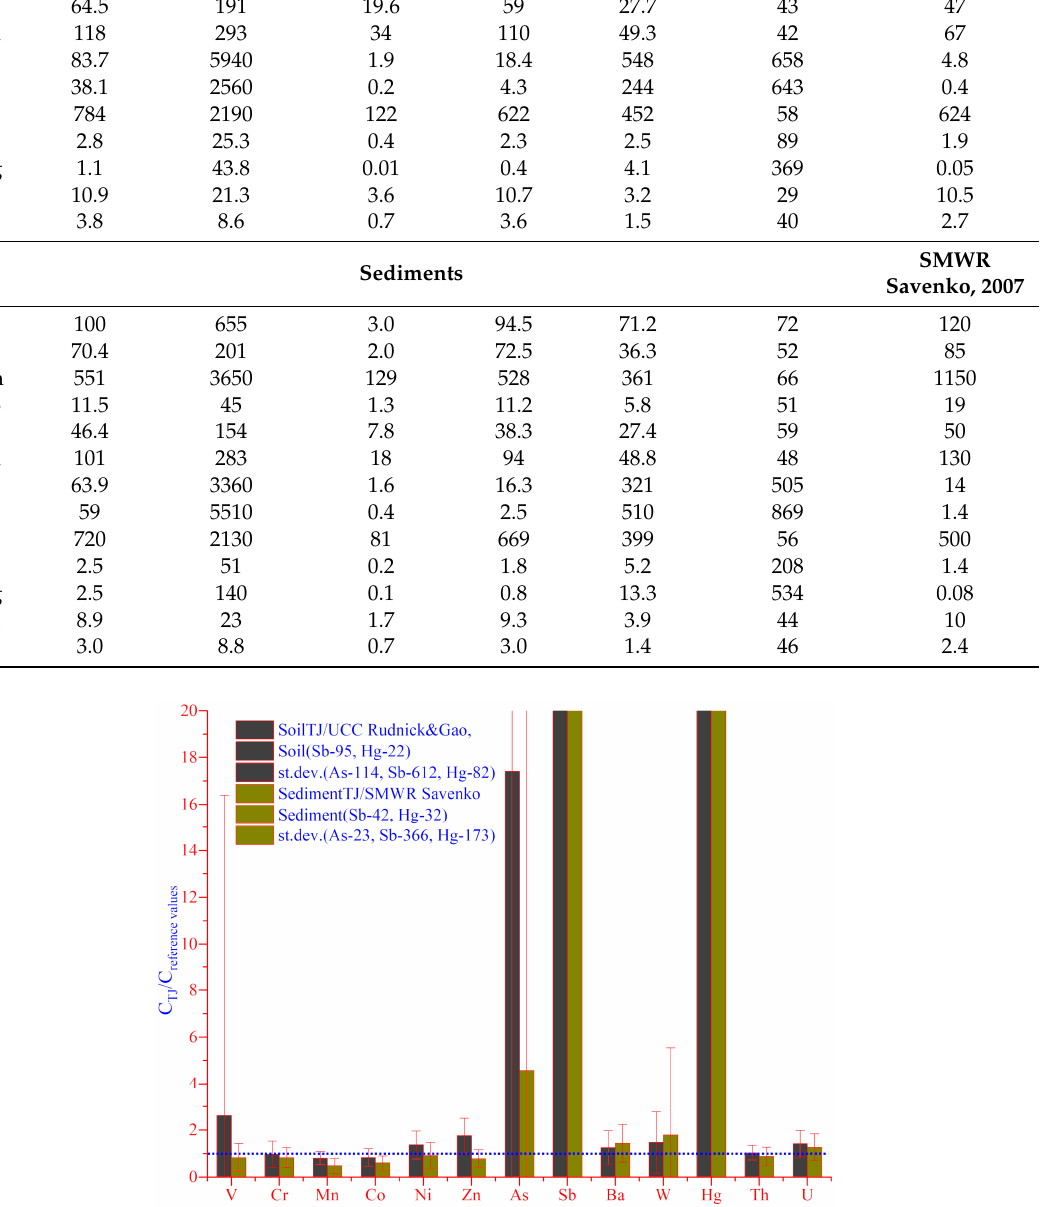
Figure 2. Column chart illustrating the distribution of investigated elements in soils and sediments (Mean ± St.Dev), normalized by reference materials.